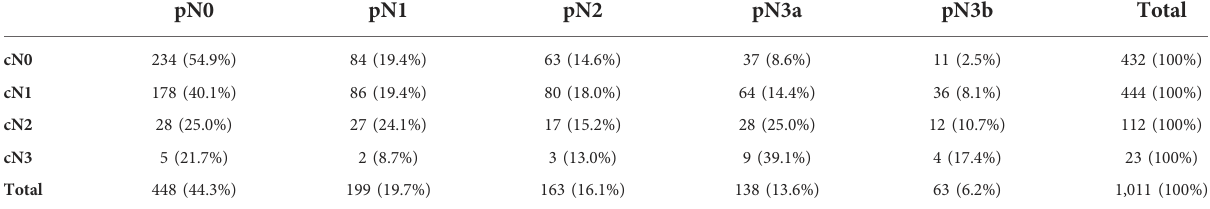
TABLE 3 Discrepancy between clinical N stage and pathologic N stage.